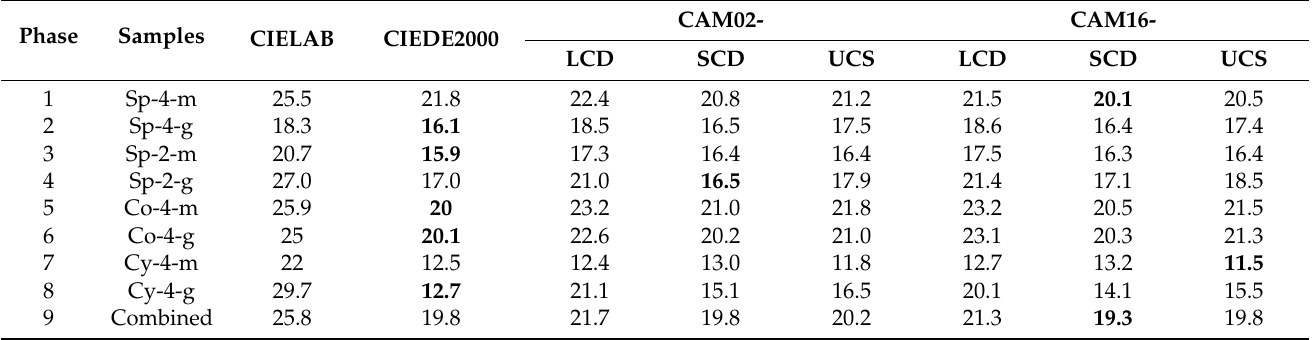
Table 8. STRESS values [25] achieved by the eight color-difference formulas based on the values of exponent b (power function) shown in Table 7. Numbers in bold indicate the best color-difference formula for each phase.